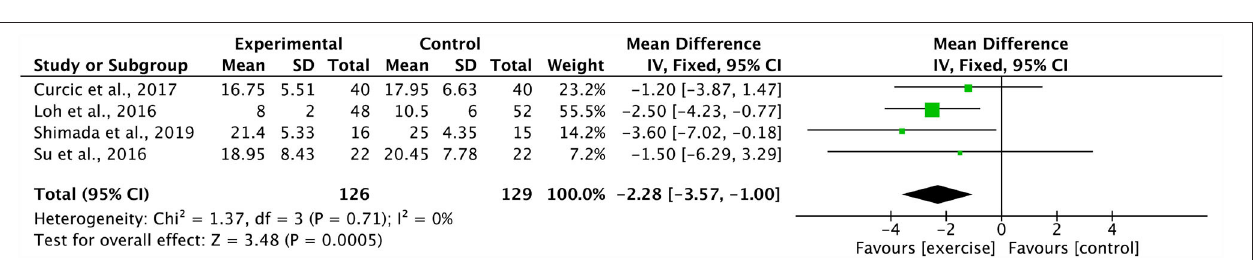
FIGURE 2 | The effects of aerobic training on PANSS positive scores.